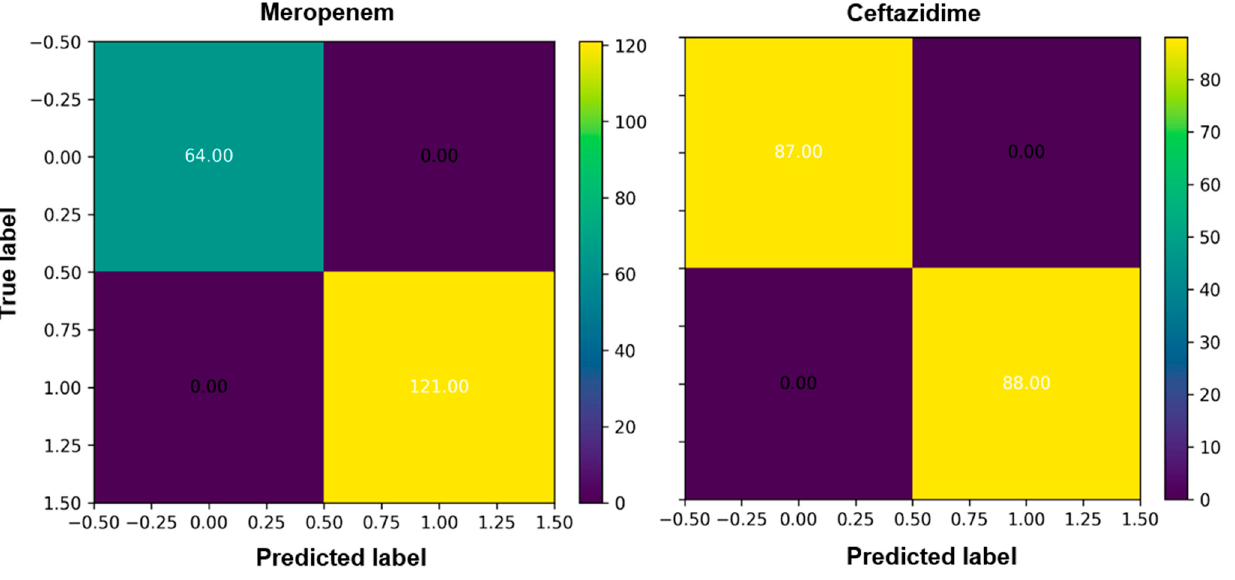
Figure 3. Confusion matrix for the gene expression values of P. aeruginosa isolates with a threshold set at 0.5. Rows represent the true transcriptomic values and columns represent the predictions.